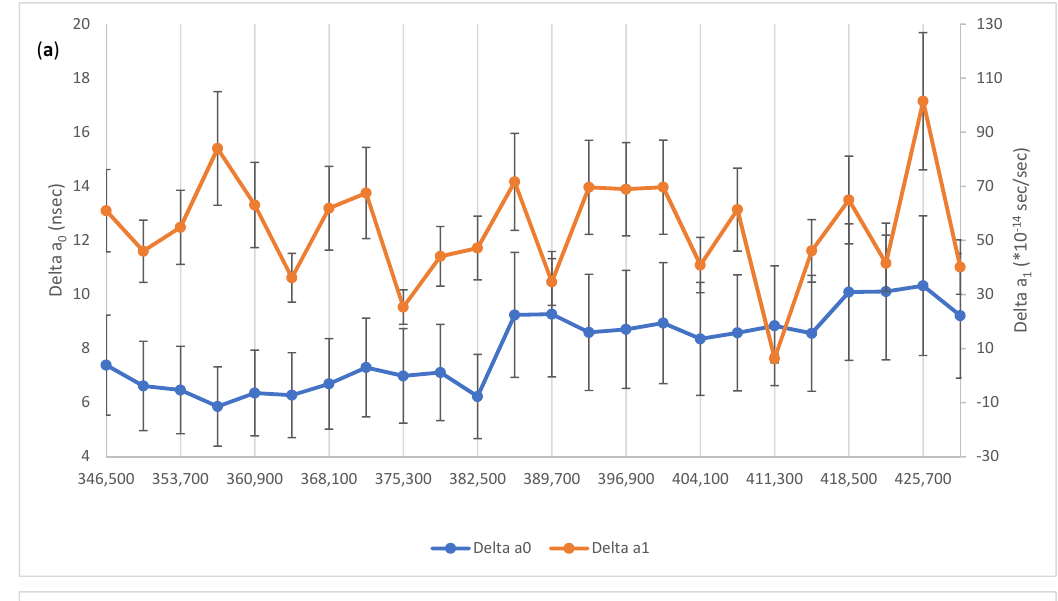
Figure 11 . Pre-fit (dots) and post-fit (diamonds) residuals of ( a ) X, ( b ) Y, ( c ) Z, and ( d ) T for R01. Length of arc for fit is 1 h. Different colours denote different ephemeris blocks.